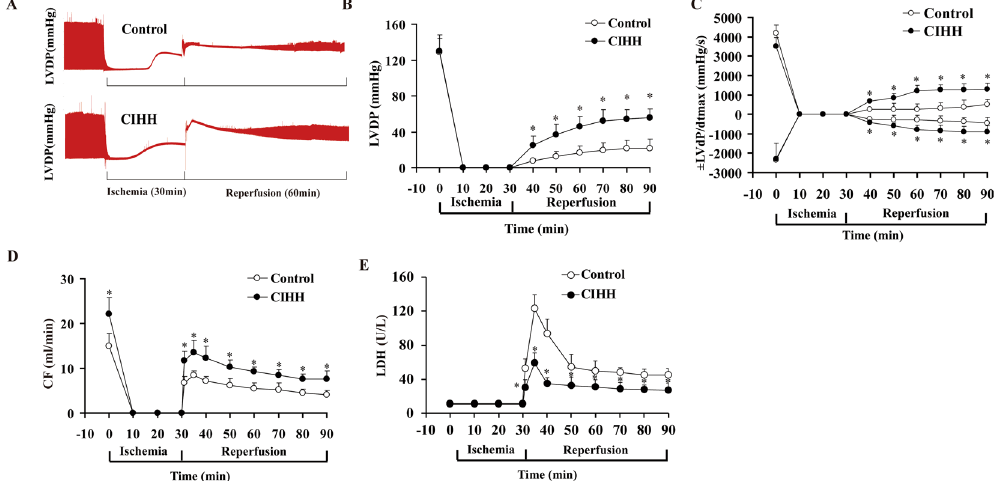
Figure 1. Effect of CIHH on the cardiac function, Coronary flow, and LDH in isolated rat hearts. CIHH treatment consisted of a procedure of 30 min ischemia and 60 min reperfusion. ( A ) Original recordings of left ventricular pressure. ( B , C ) Effect of CIHH on LVDP and ± LVdP/dt max . ( D ) Effect of CIHH on coronary flow. ( E ) Effect of CIHH on LDH activity in coronary effluent. CIHH: chronic intermittent hypobaric hypoxia. All data were expressed as mean ± SD, n = 6 for each group. * P < 0.05 vs control